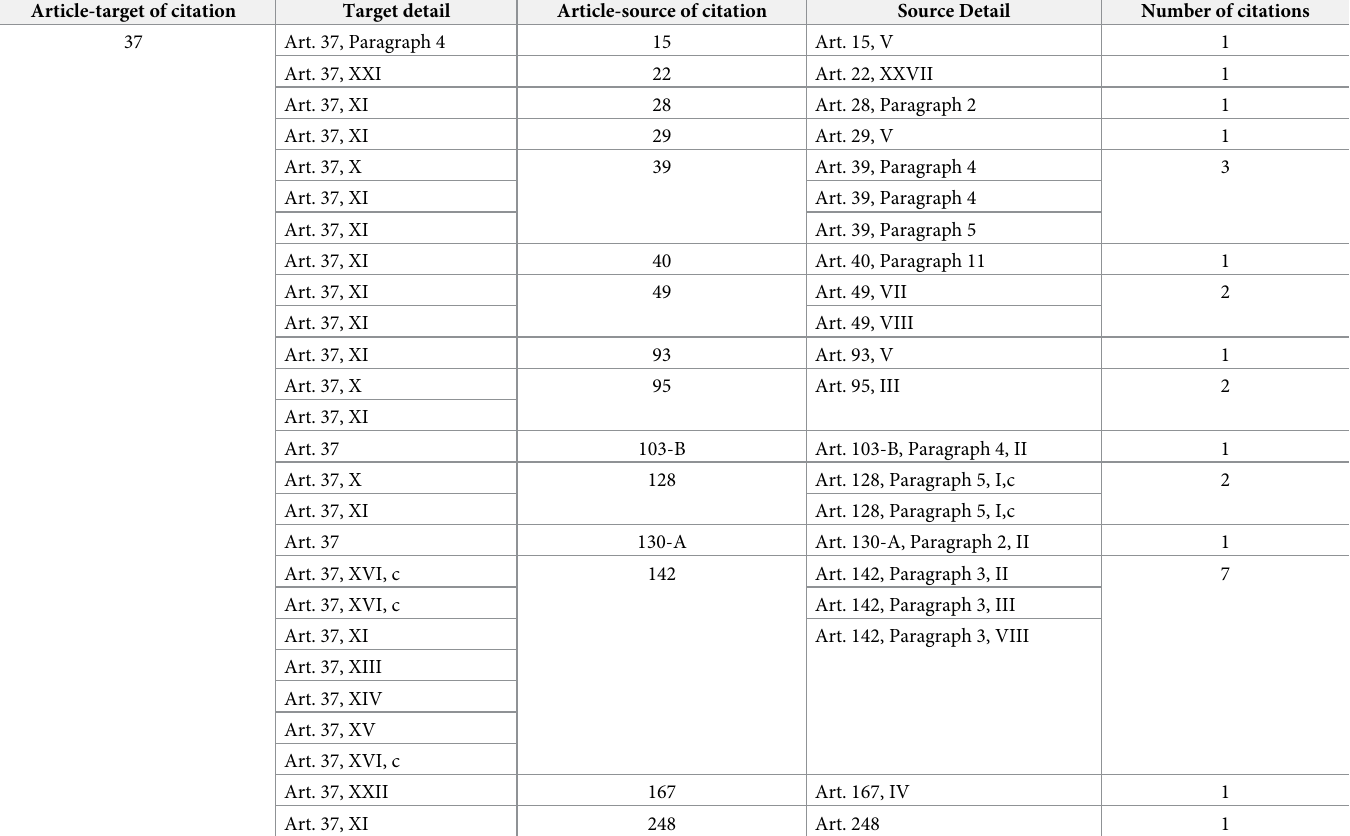
Table 1. Article 37 citation mapping